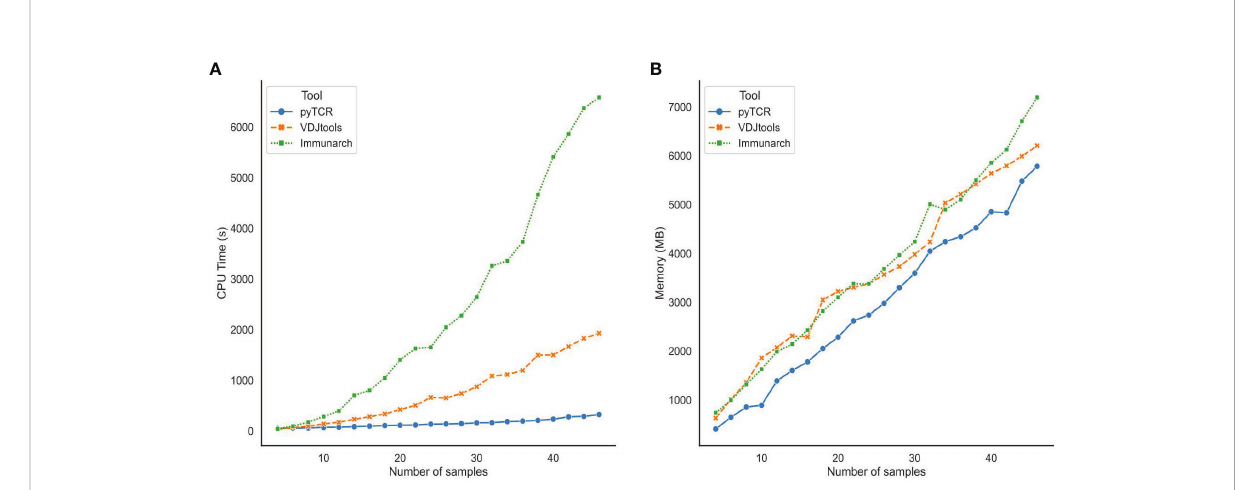
FIGURE 2 Central Processing Unit (CPU) time (A) and Memory usage (B) for subsamples of the COVID19-BWNW dataset for overlap analysis. Each dot on the line plot represented the average of 10 runs for different input